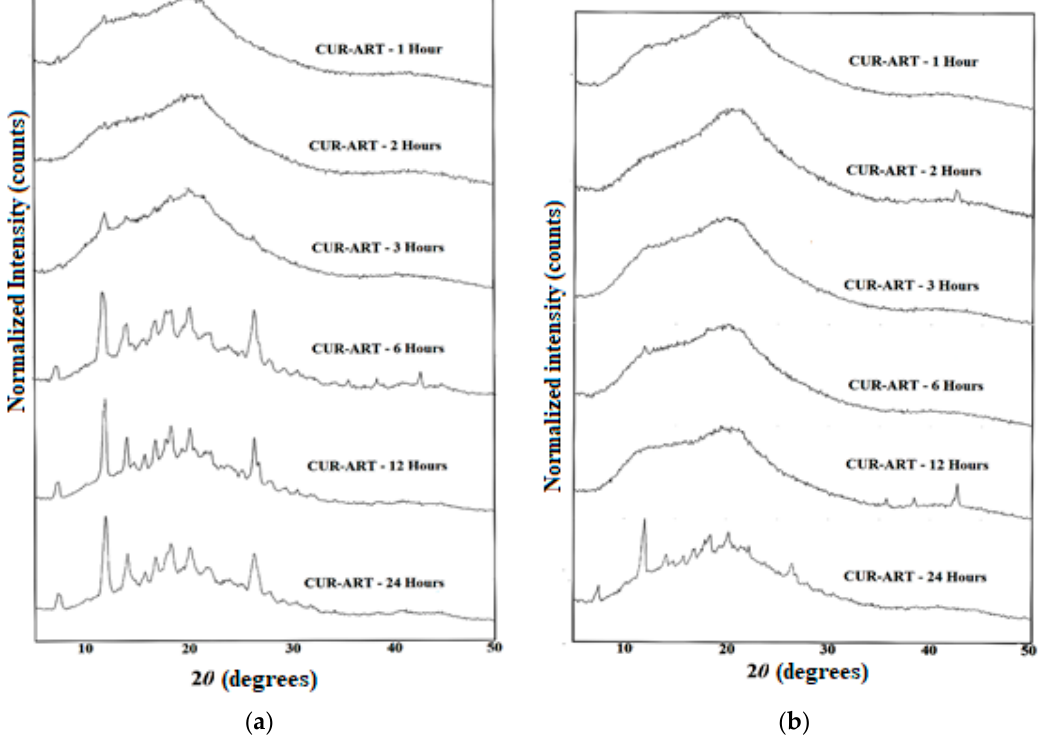
Figure 6. CUR-ART phase stability study PXRD patterns at different time intervals in Simulated Gastric Fluid (SGF), pH = 1.2 ( a ); and Simulated Intestinal Fluid (SIF) media, pH = 7 ( b ). The precipitated polymorph of ART is form II.